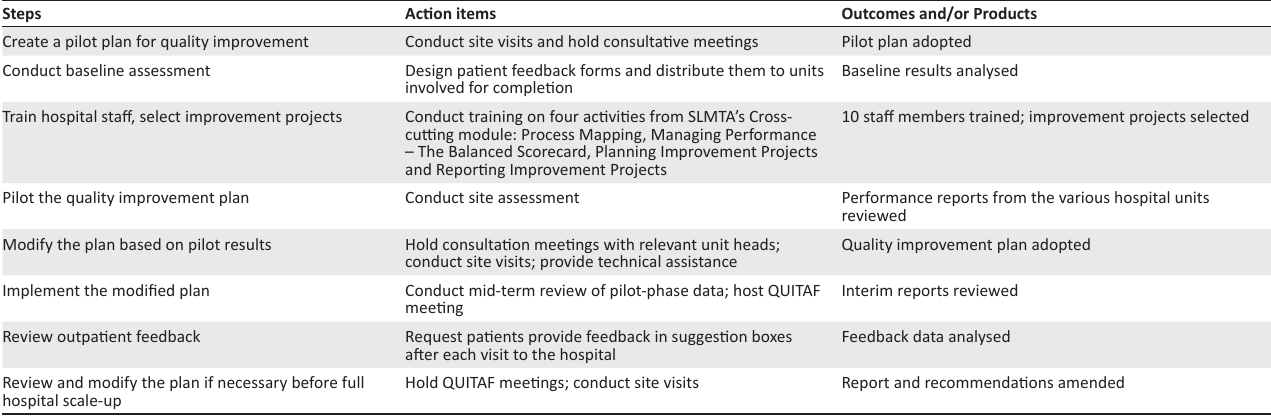
TABLE 1: Quality improvement roadmap for Regional Hospital Buea.